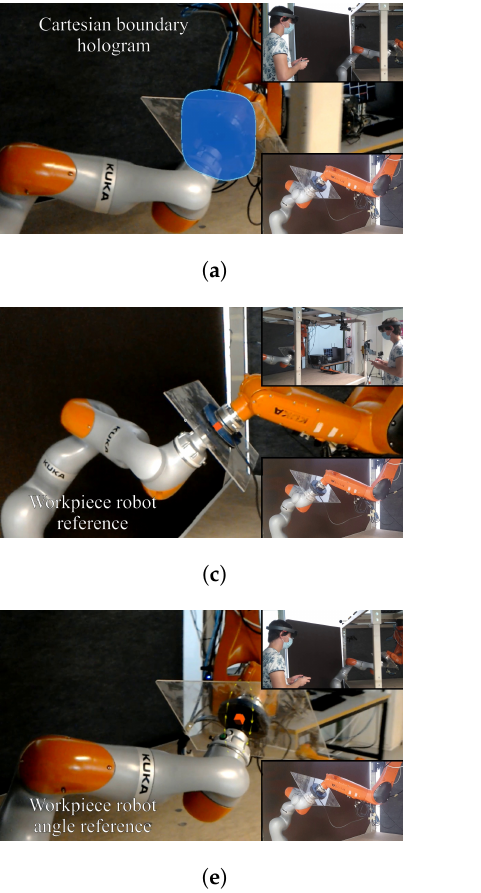
Figure 9. First experiment: frames of the video showing the functionalities of the proposed AR-based interface. See the video at https://media.upv.es/player/?id=a64014f0-8a5a-11ec-ac0a-b3aa330d3dad (accessed on 26 April 2022) [81]. ( a ) Video: 0 m 20 s. ( b ) Video: 0 m 23 s. ( c ) Video: 0 m 30 s. ( d ) Video: 0 m 36 s. ( e ) Video: 0 m 43 s. ( f ) Video: 0 m 57